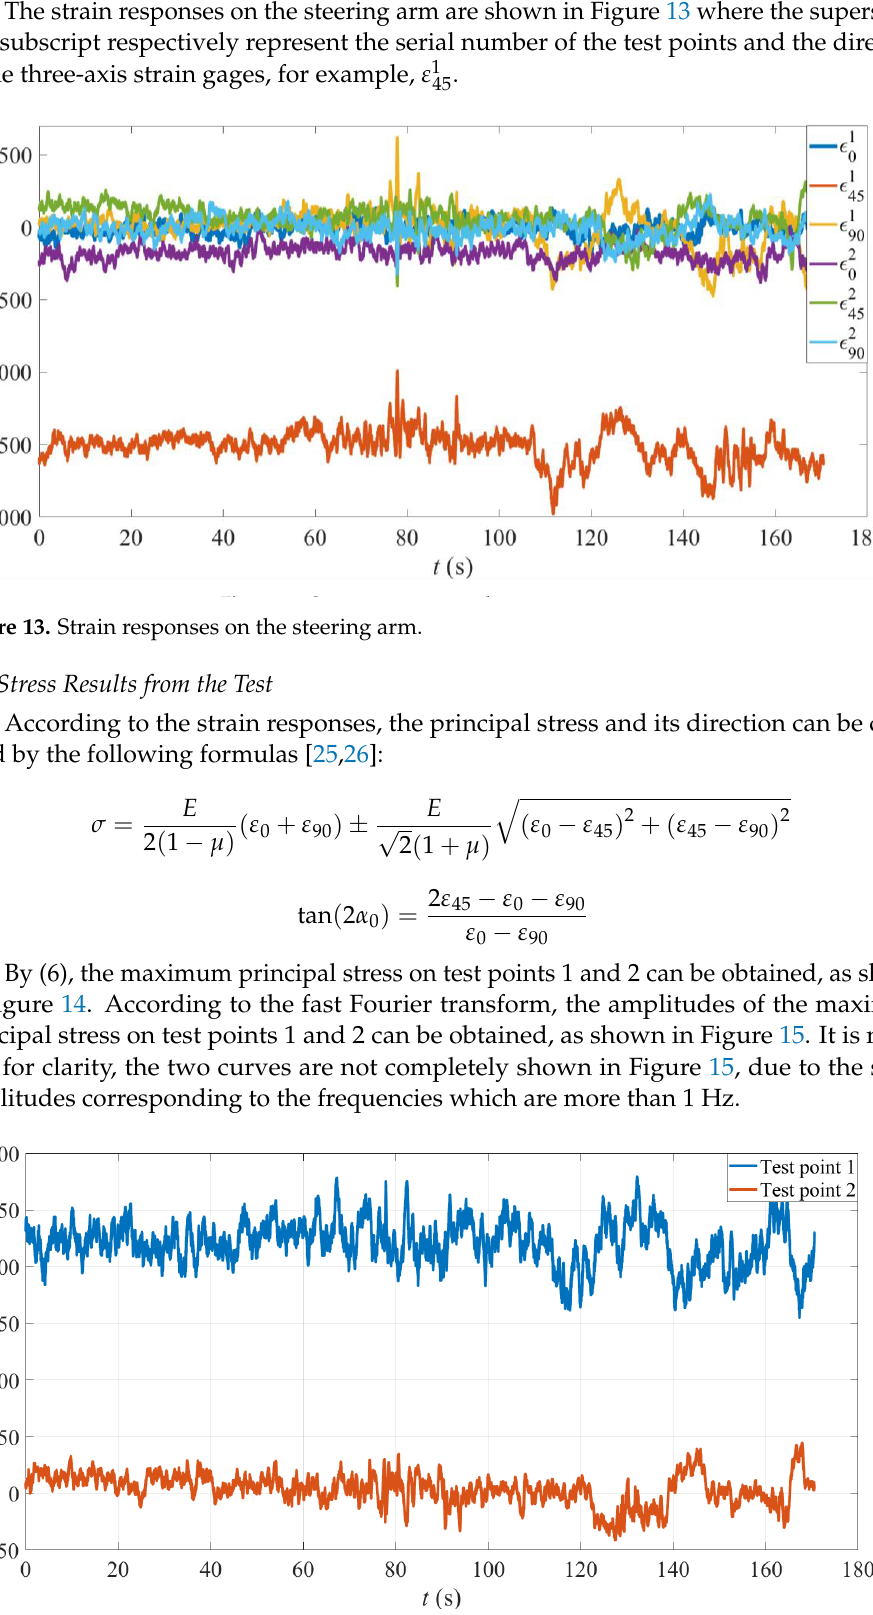
Figure 14. Responses of the maximum principal stress on test points 1 and 2.